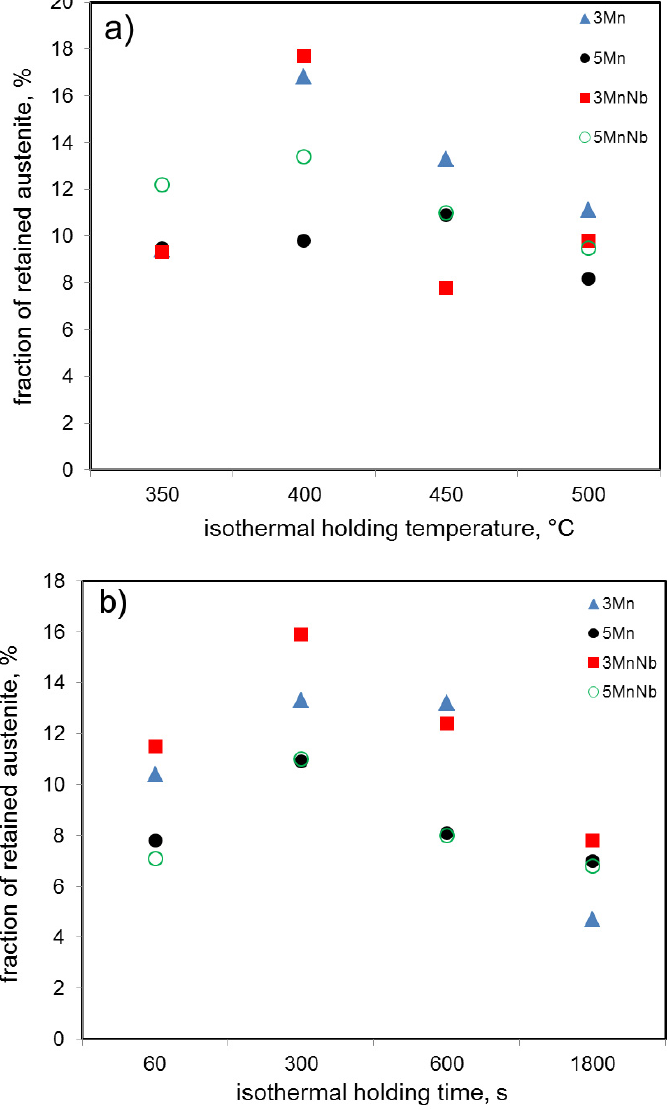
Figure 3. ( a ) Influence of temperature on the amount of retained austenite for steels isothermally held for 300 s; ( b ) Influence of isothermal holding time on the amount of retained austenite for steels treated at 450 °C.